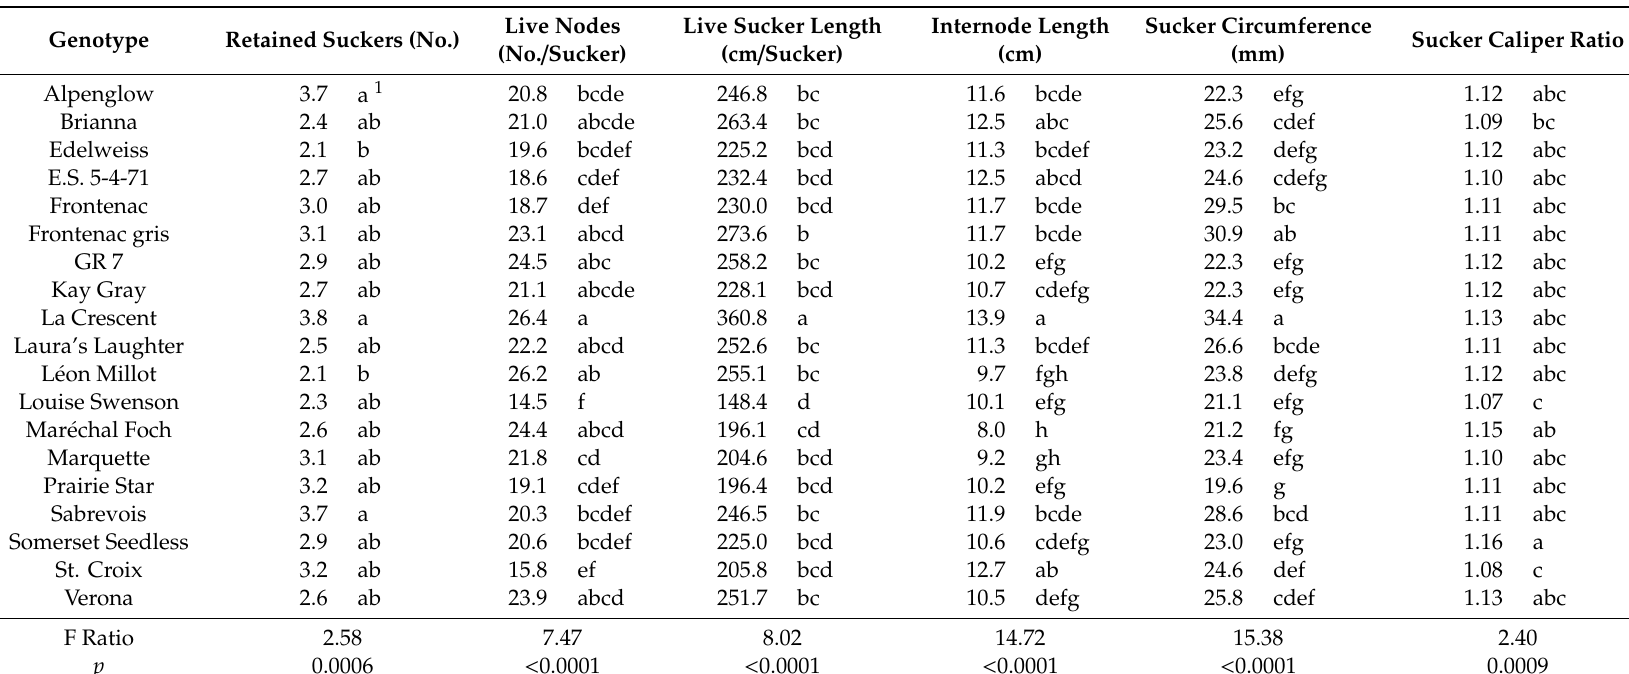
Table 2. Sucker metrics for re-established grapevine suckers trained in 2019 after winter kill during the 2018–2019 winter at the NDSU Horticulture Research Farm near Absaraka, ND,